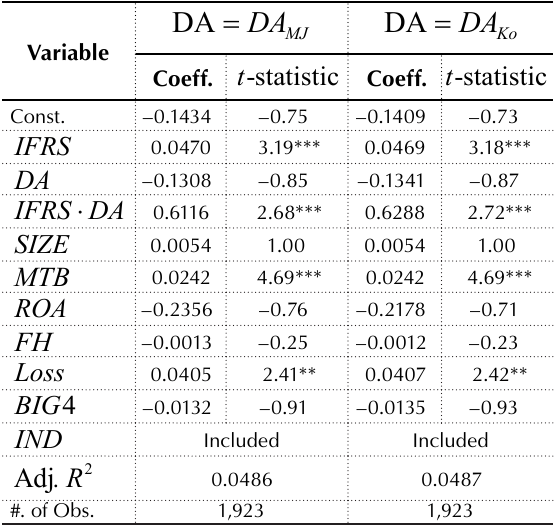
Table 5. Regression analysis results